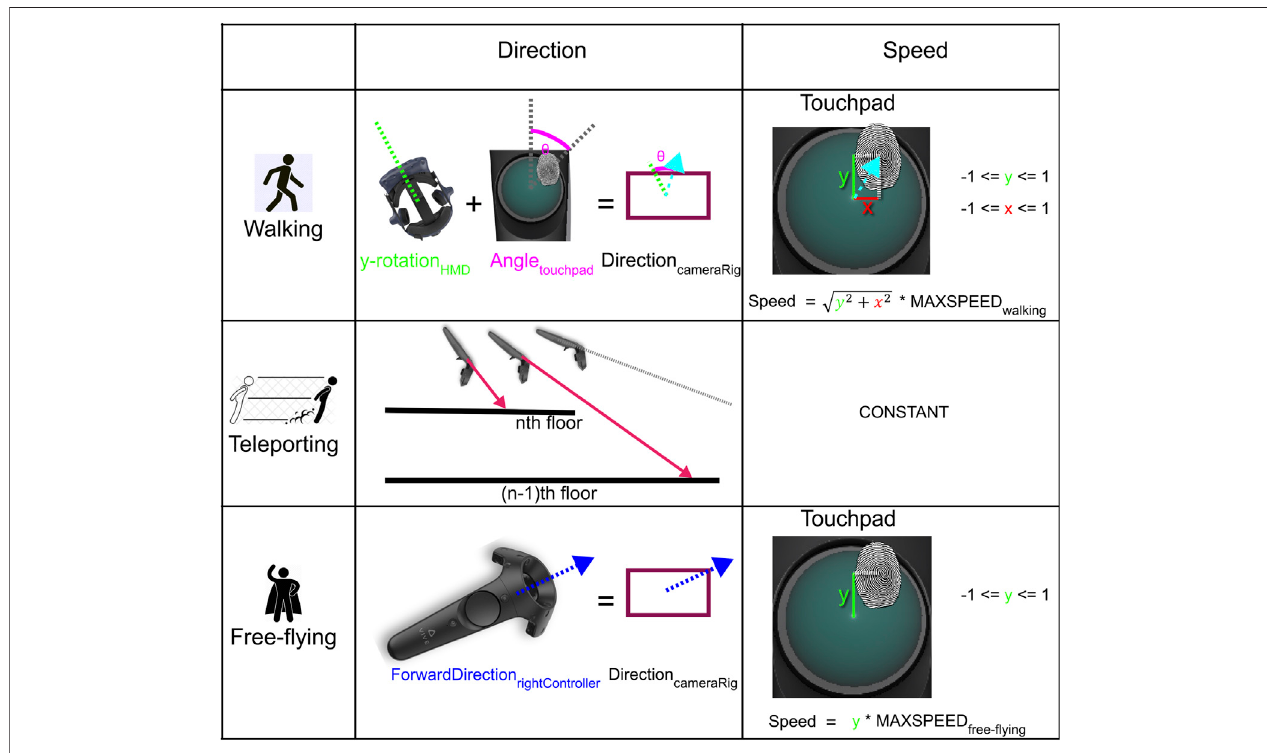
FIGURE 6 | Advanced illustration of how direction and speed are calculated from user input, for each navigation method.